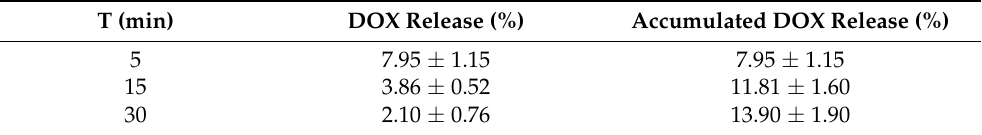
Table 2. Drug release stimulated through pulmonary capillary constriction (mean ± standard deviation, n =